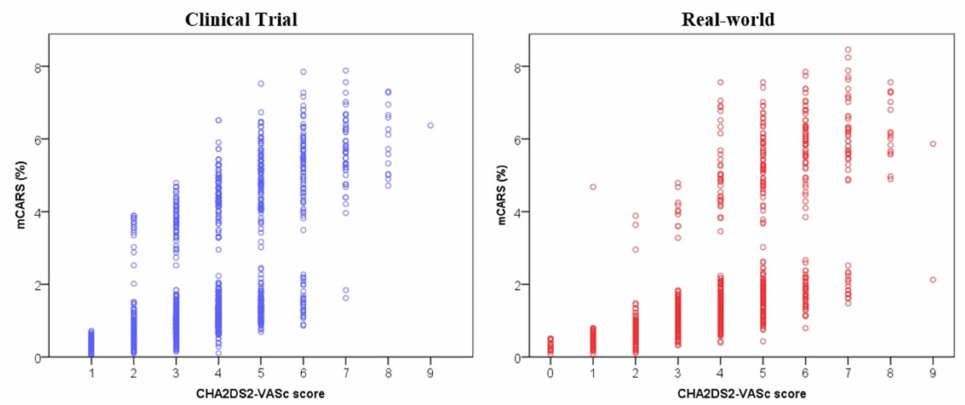
Figure 2. mCARS vs. CHA 2 DS 2 -VASc score in clinical trials and the